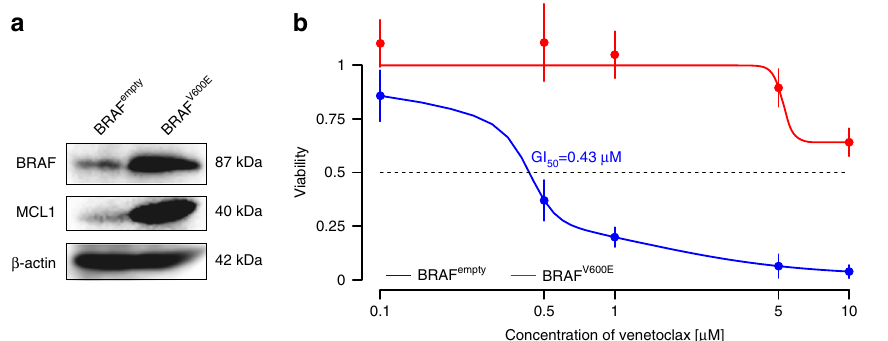
Fig. 3 Overexpression of oncogenic BRAF in the OCI-LY19 cell line. a Western blot analysis of BRAF and MCL1 in the BRAF V600E overexpressing OCI-LY19 cell line vs. its empty vector control. b Growth inhibition of BRAF V600E transfected OCI-LY19 cells and the empty vector control is shown as a function of the concentration